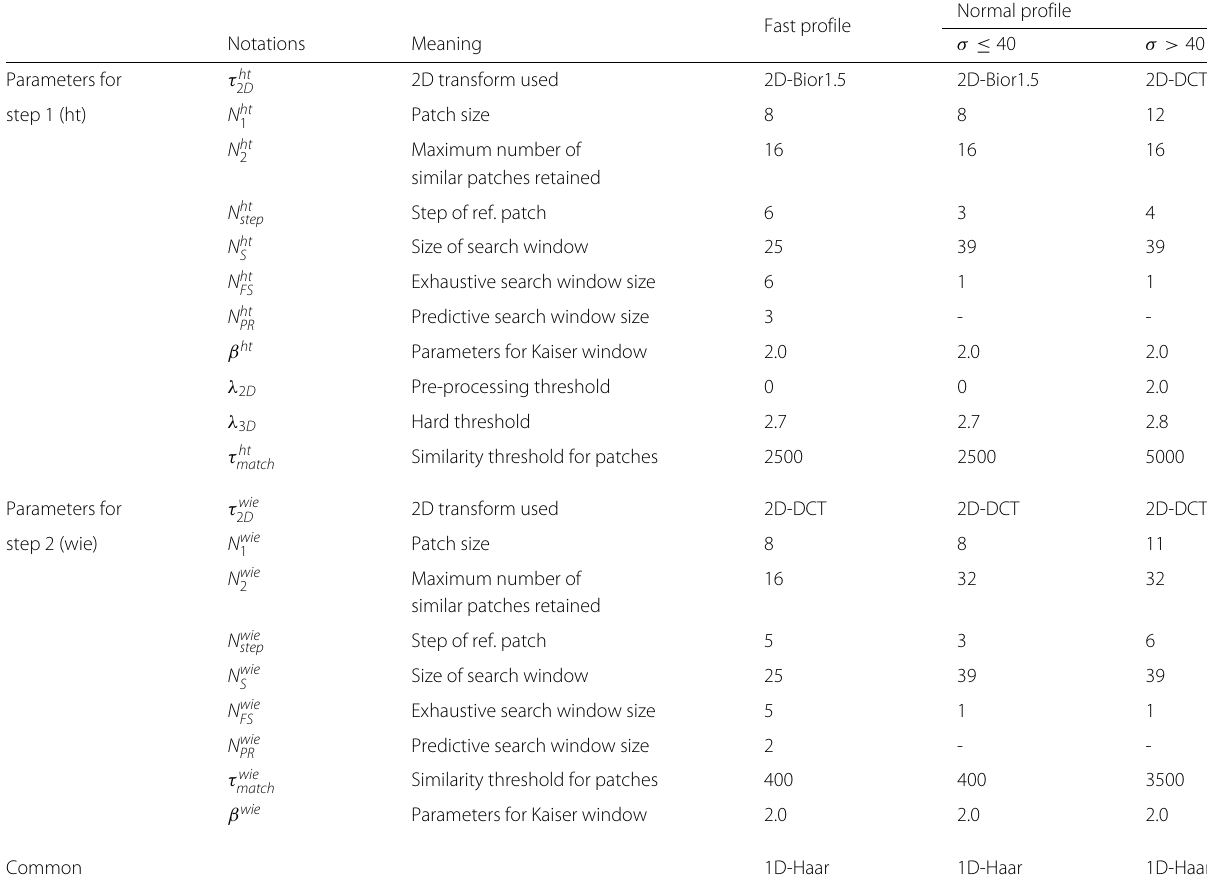
Table 1 Parameterized setup for the wavelet profile of BM3D